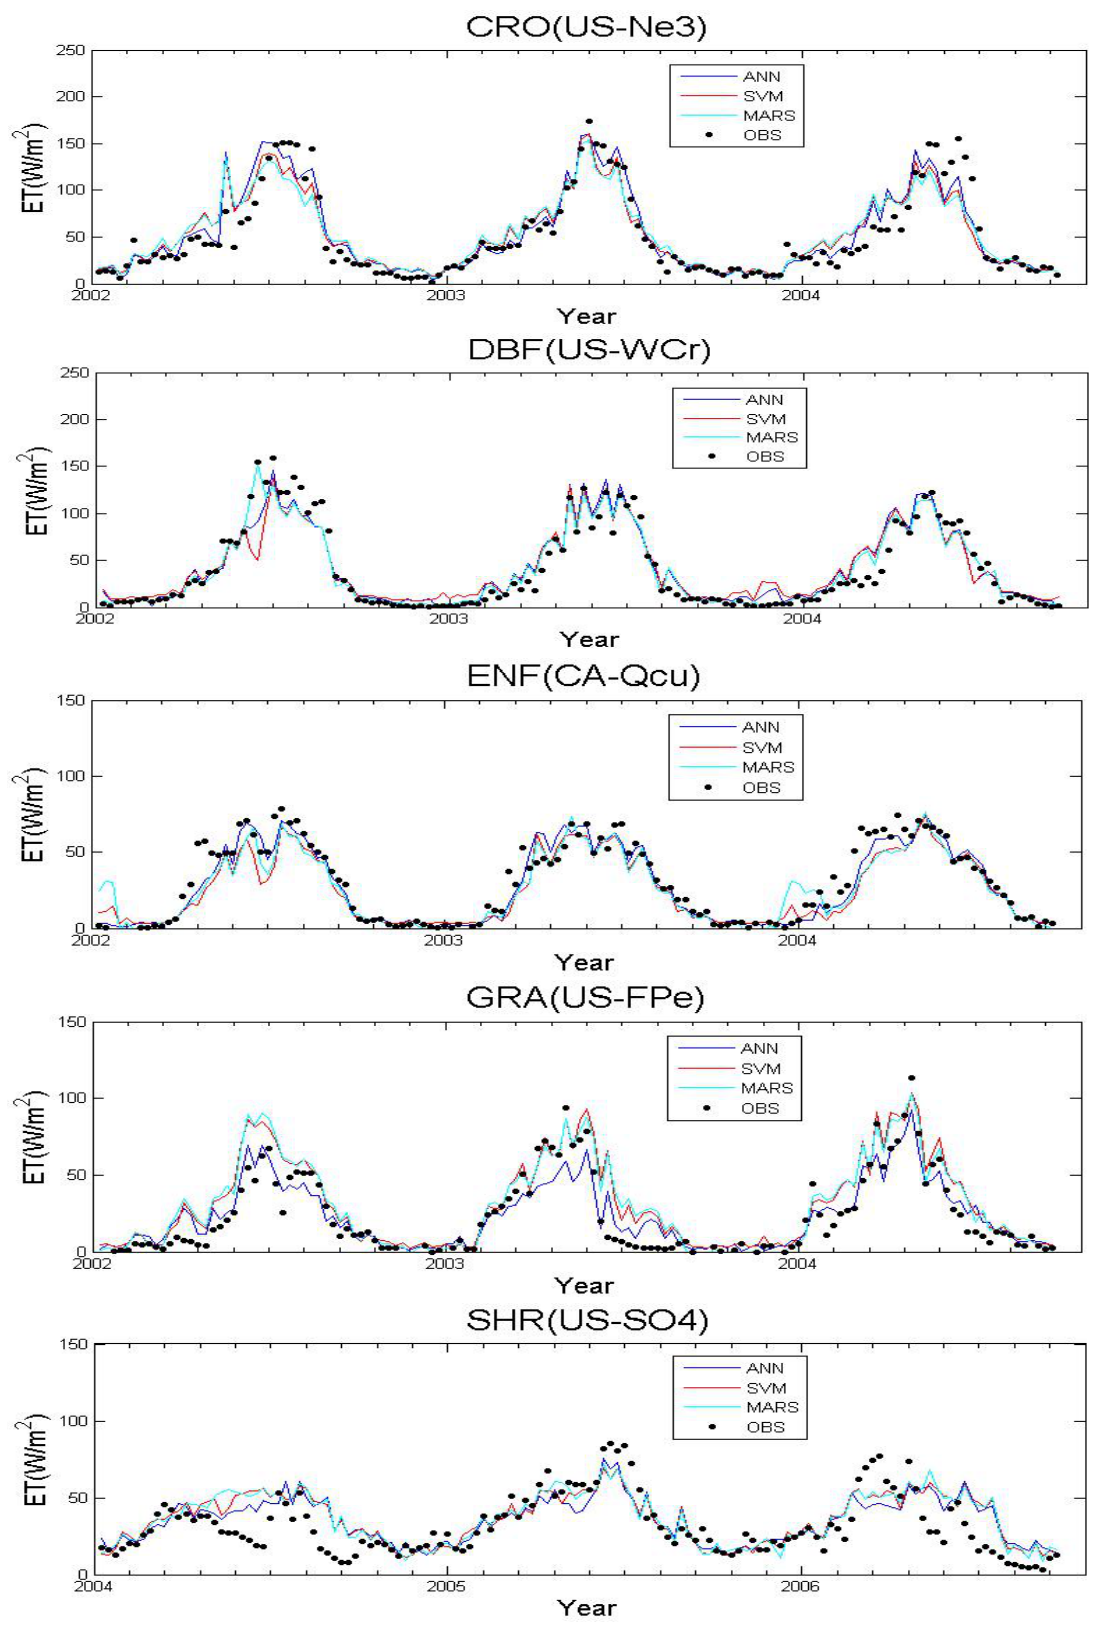
Figure 6. Examples of the eight-day terrestrial latent heat flux (LE) average as measured and estimated